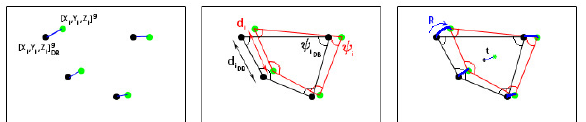
Figure 10: Pattern matching and transformation calculation for intersections detected in the camera (green dots) and database matches (black)